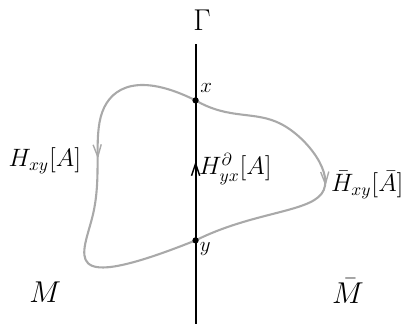
¯ (cid:0) ¯ H xy [ A ] − 1 H xy [ A ]